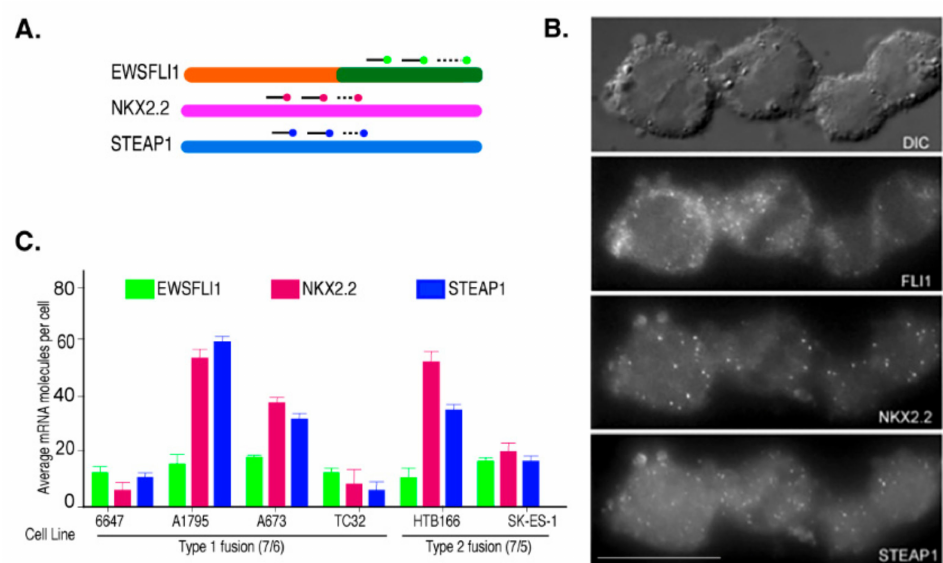
Figure 1. Single-molecule RNA analysis of ES cells: ( A ) A graphical representation of smFISH probes binding to the target RNA. Multiple target RNAs can be imaged simultaneously using different fluorophores for different target RNAs. ( B ) A representative image of HTB 166 cells showing the smFISH signal for EWSFLI1, NKX2.2, and STEAP1 RNAs, where the probes for FLI1, NKX2.2, and STEAP1 mRNAs were coupled with TMR, Texas Red, and Cy5, respectively. The first panel is the bright field image, and the remaining panels are raw images with a merge of 16 z stacks for each filter. ( C ) The average number of FLI1, NKX2.2, and STEAP1 mRNA molecules obtained after counting at least 100 cells for each cell line. The error bars indicate a 95% confidence interval. The scale bar is 5 µ m. Each experiment was performed in